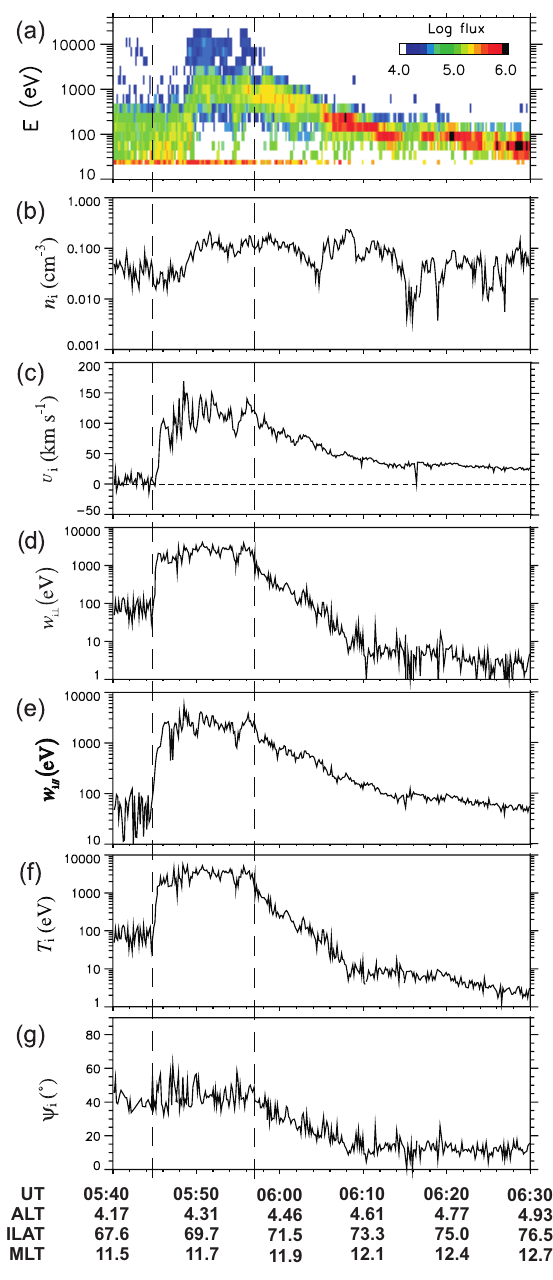
Fig. 3. Overview of a transverse O + ion heating event on 28 September 2001, between 05:40 and 06:30UT: (a) time-energy spectrogram of O + ions, (b) O + ion density in cm − 3 , (c) upward mean velocity in kms − 1 , (d) perpendicular mean energy in eV, (e) parallel mean energy in eV, (f) temperature in eV, and (g) apex an- gle in ◦ . The vertical dashed lines indicate the boundaries of the heating